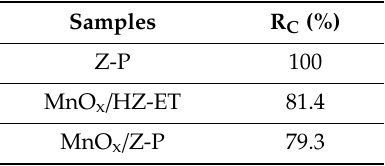
Figure 2. SEM images of the catalysts. ( a ) MnO x /Z-P, ( b ) MnO x /HZ-ET.